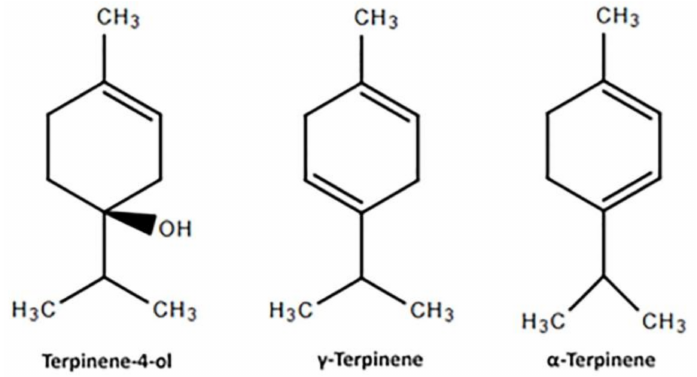
Figure 1. Major components of tea tree